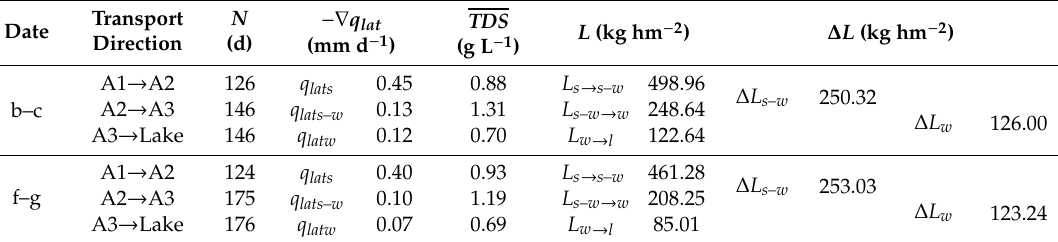
Table 8. Horizontal salt transport of groundwater.